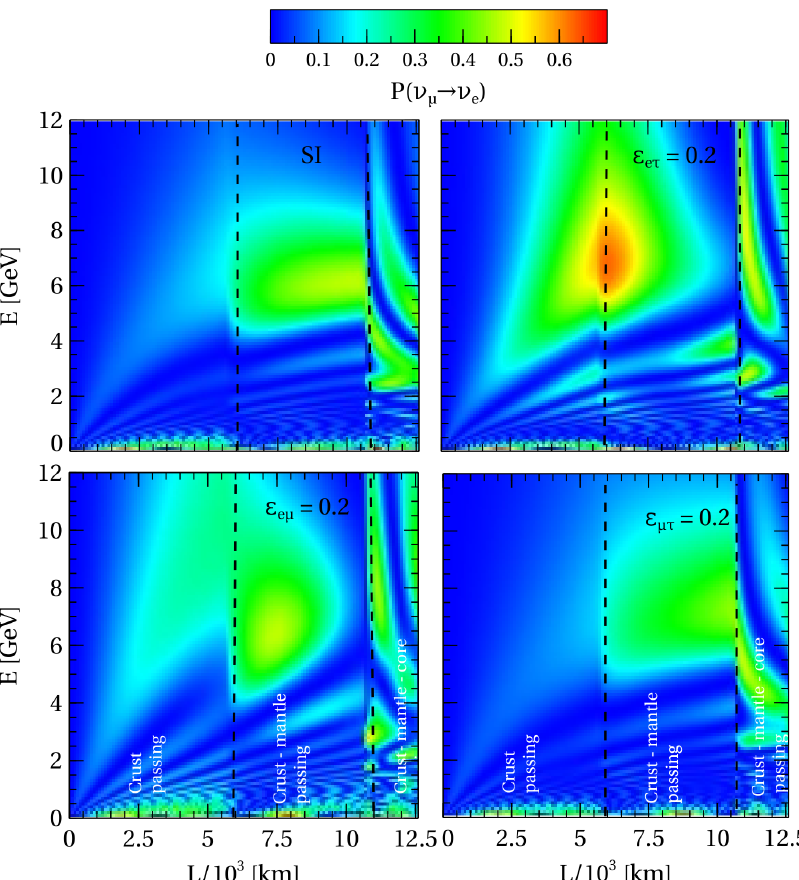
Figure 9 . Oscillograms of ν µ → ν e transition probability as a function of baseline L and energy E . Top left panel corresponds to SI case and other three panels correspond to the cases in presence of non-zero positive NSI parameters (taken one-at-a-time with a strength of 0.2 as shown in the legends). The values of the oscillation parameters used in this plot are taken from table 2 with θ 23 = 45 ◦ and